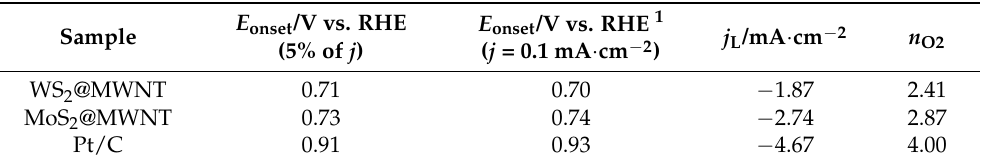
Table 1. ORR (oxygen reduction reaction) activity parameters (E onset , j L and n O2 ) for WS 2 @MWNT, MoS 2 @MWNT and